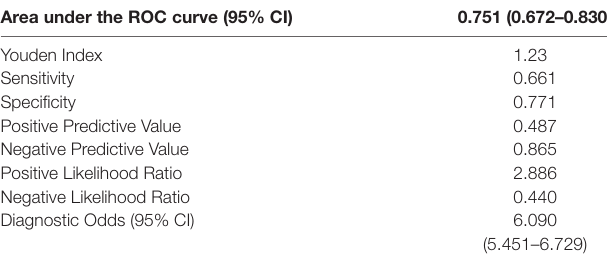
TABLE 4 | Accuracy of abdominal visceral fat in predicting cognitive impairment ( n = 234). Area under the ROC curve (95% CI)